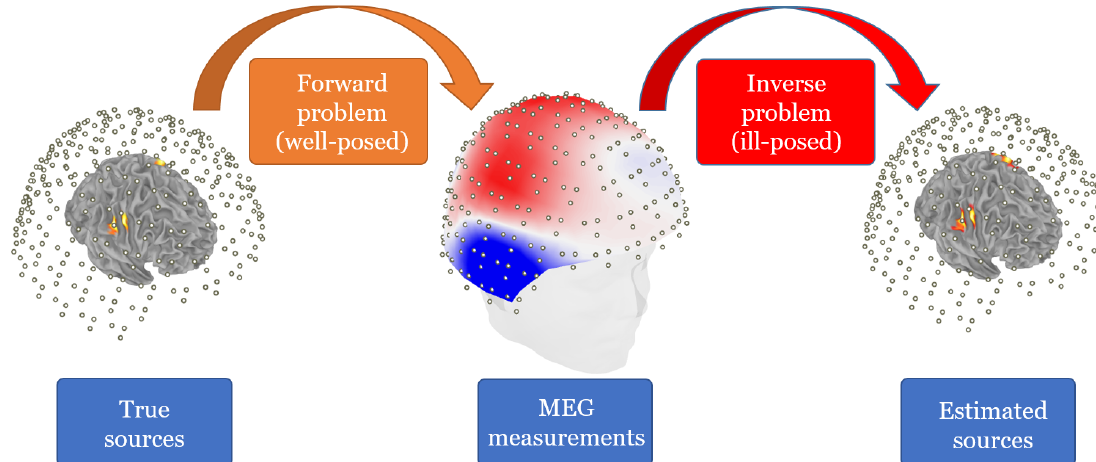
Figure 1. MEG forward and inverse problems. In the forward problem, a well-posed model maps the true sources activation to the MEG measurement vector. In the inverse (and ill-posed) problem, an inverse operator maps the measurement vector to the estimated sources